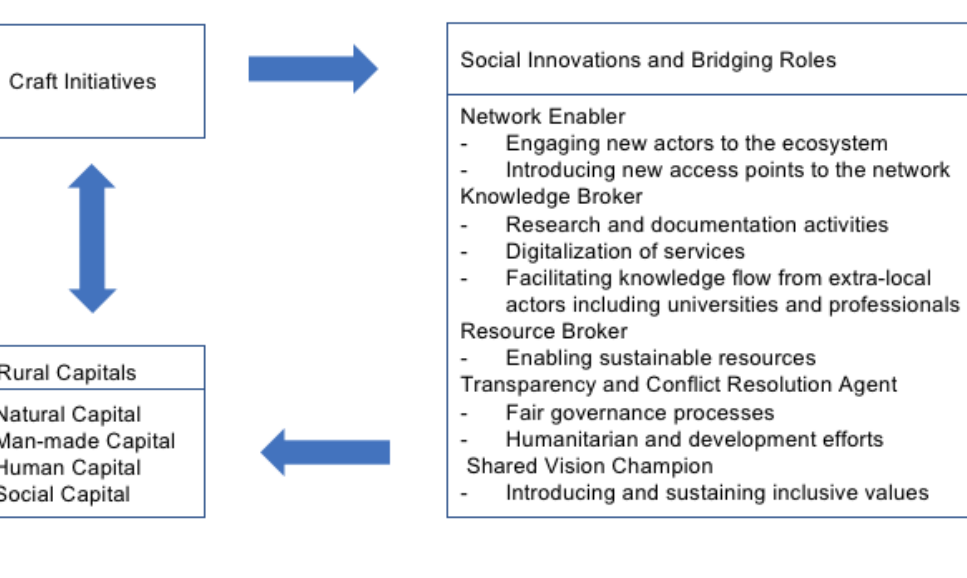
Figure 1 Identified social innovations and their bridging